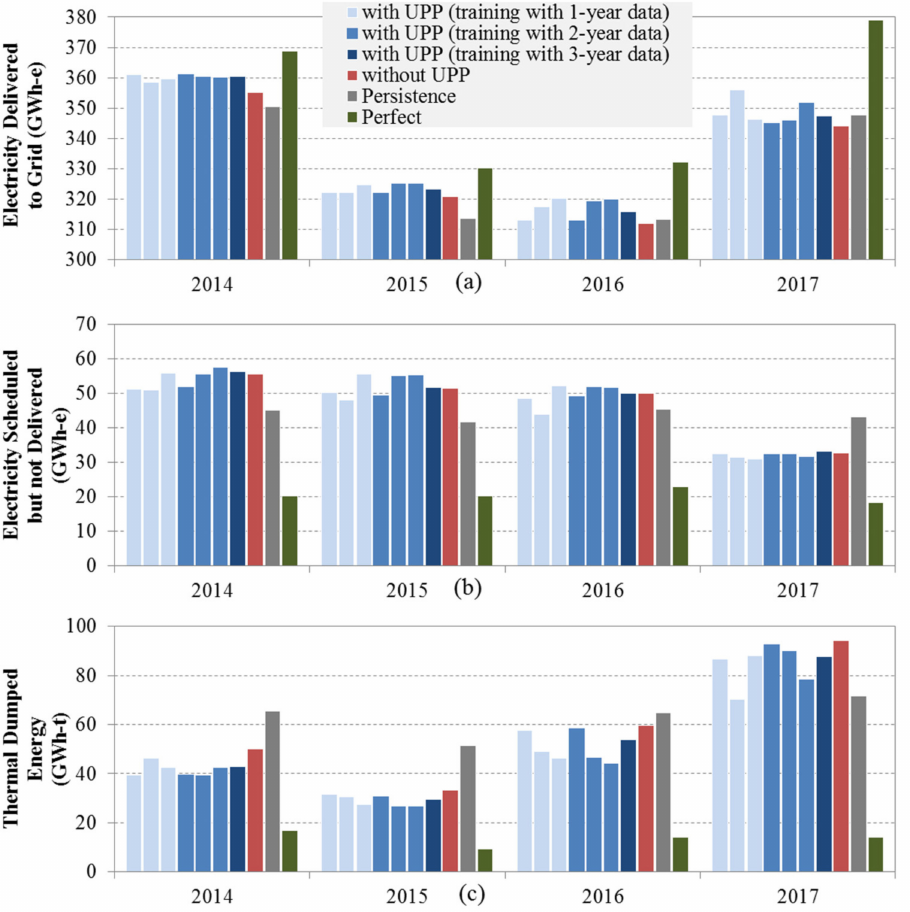
Figure 14. Total annual electricity delivered to the grid ( a ), scheduled but not delivered ( b ) and thermal dumped energy ( c ) for the simulated years with optimized